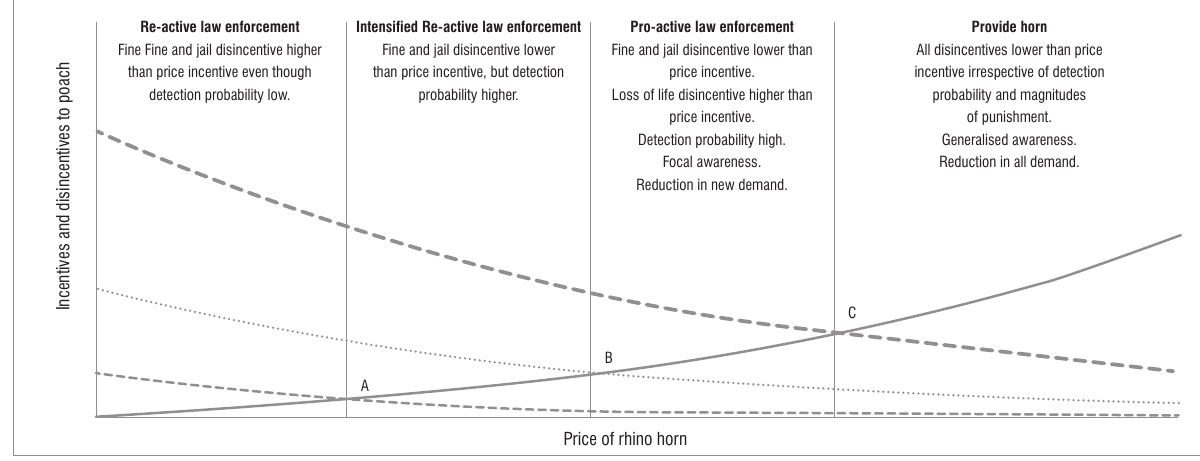
Figure 2. Expected relationships between incentives as well as disincentives to poach and the price of rhino horn. Participants expected non-linear increases in poaching incentives (solid line) with an increase in the price of rhino horn. Disincentives to poach varied – re-active law enforcement (lower dashed line) as was the case until recently, relied on jail sentences and fines as sufficient deterrents to poach. When incentives to poach exceed re-active law enforcement disincentives (A), then intensified re-active law enforcement (dotted line) increases detection probabilities and serves as a disincentive. When price increases to such an extent that incentives to poach exceed intensified re-active law enforcement disincentives (B), authorities may impose pro-active law enforcement (upper dashed line) with high probabilities of detection and additional risks such as loss of life as sufficient deterrents to poach. Such activities can be complimented by focal awareness programmes directed at reducing demand. A significant critical threshold is reached when price is so high that the incentive to poach exceeds all disincentives (C). At this threshold, authorities are best placed to change tack completely and provide rhino horn in parallel with aggressive awareness